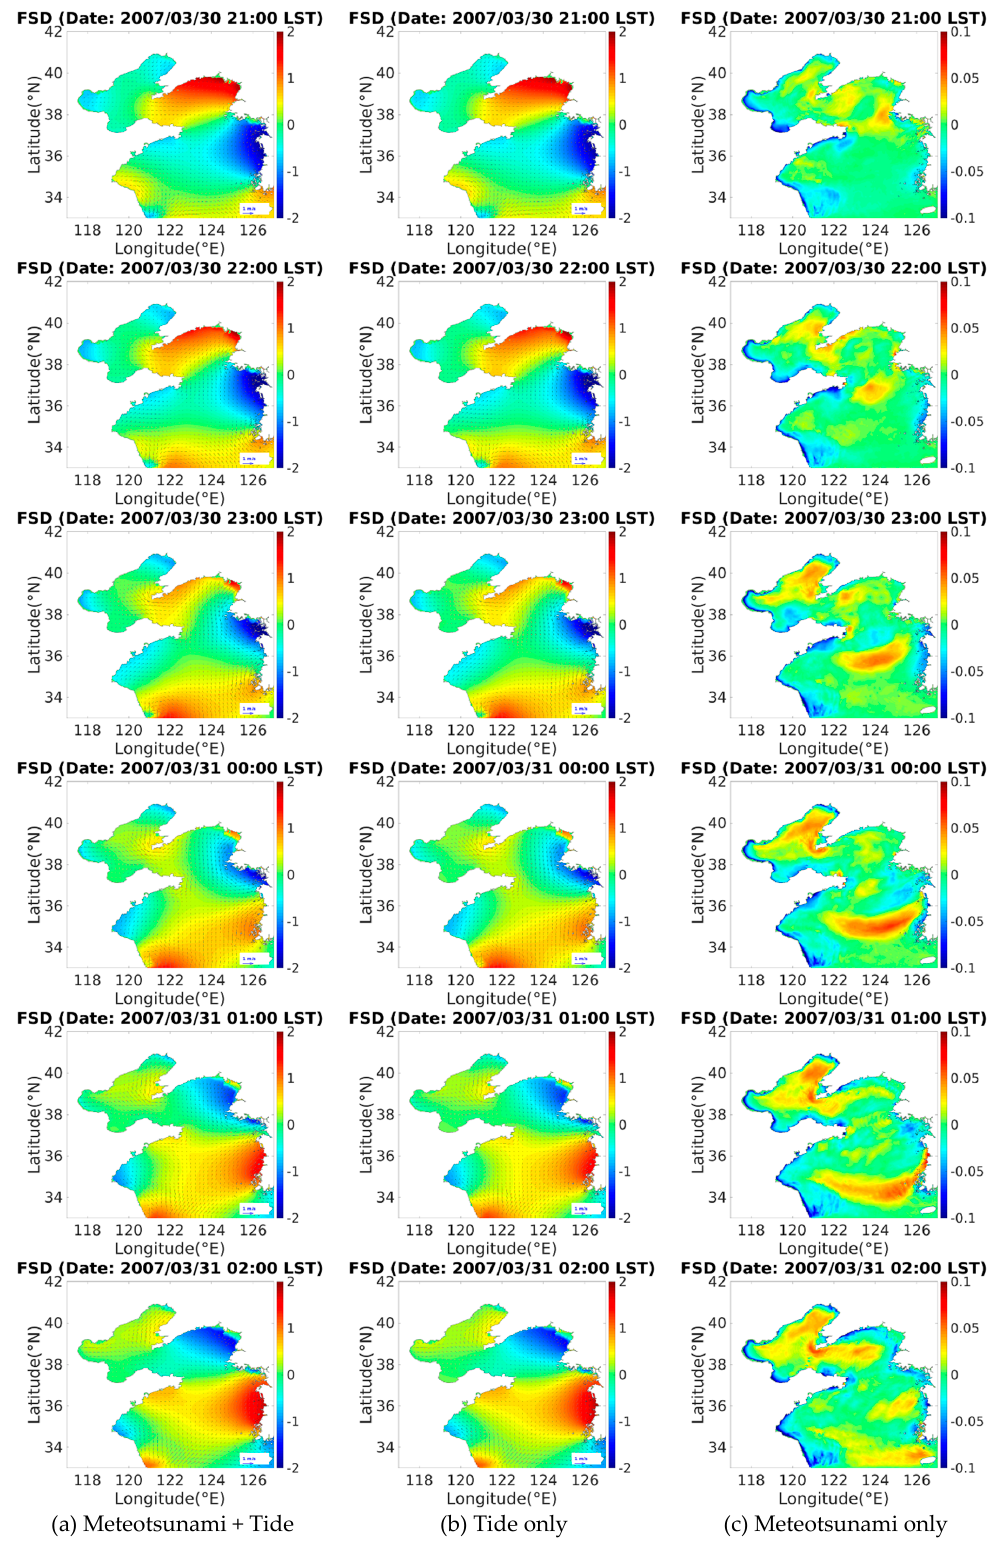
Figure 8. Comparison of the free surface displacement (FSD) change with tide modeling in the Yellow Sea during the meteotsunami that occurred in March 2007. (a ) FSD change of the meteotsunami with tide modeling; (b ) FSD change of tides; (c ) FSD change of the meteotsunami